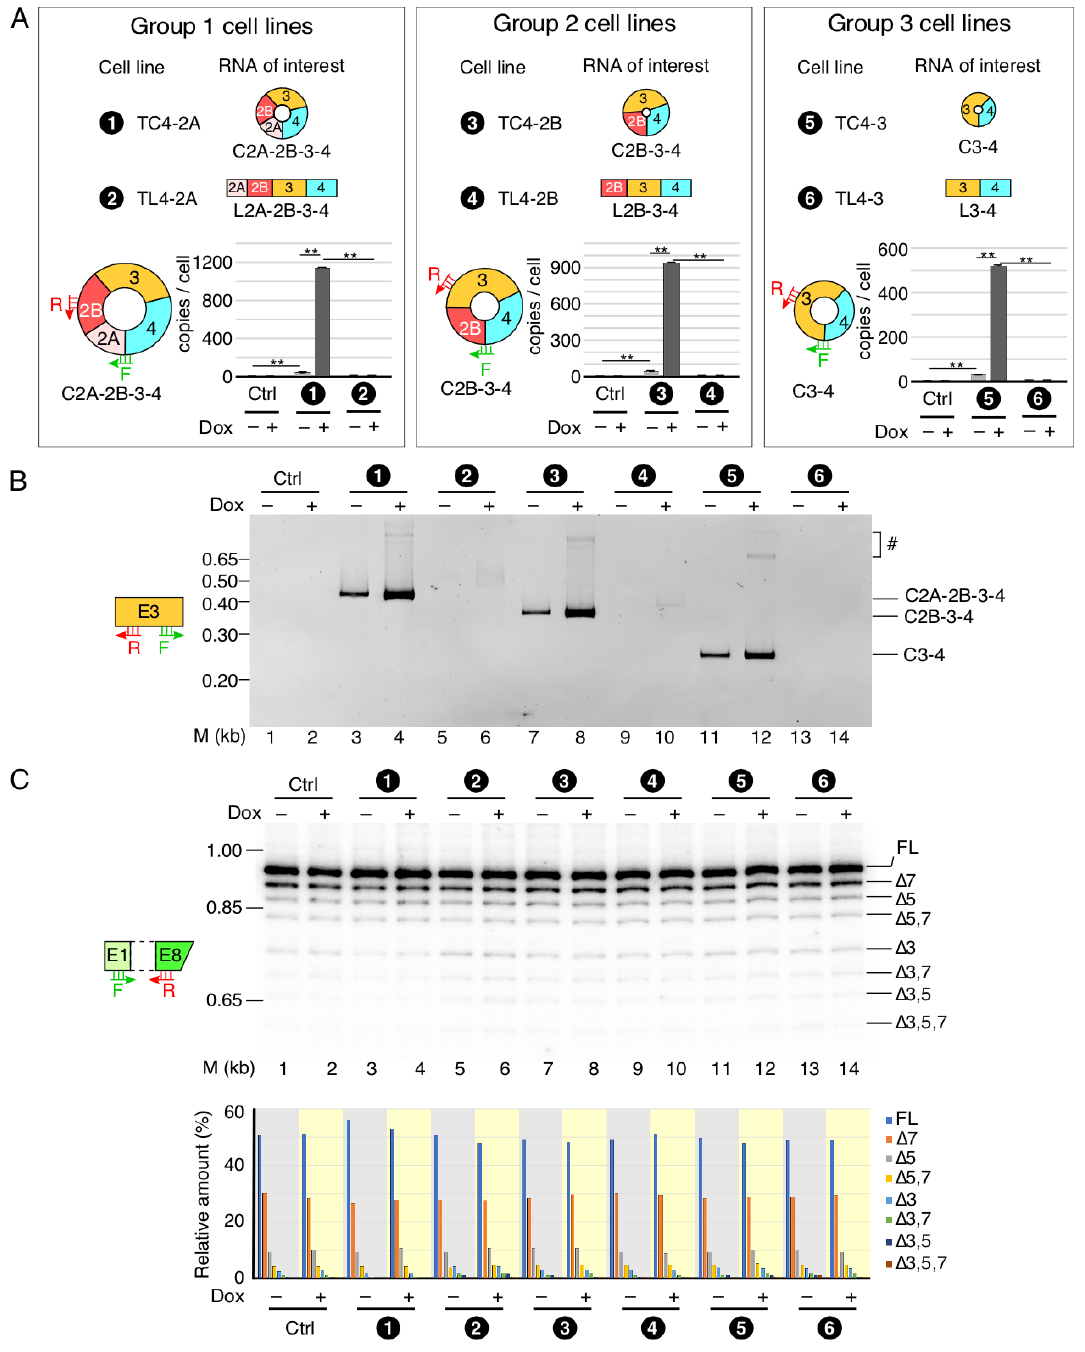
Figure 5. Comparative analysis of SMN RNA expression in stable cell lines. ( A ) Inducible expression of circRNA of interest in the established cell lines. Based on the number of exons in circular or linear transcripts, three groups of cell lines are shown. The names of each stable cell line are given as well, along with their number coding. Number coding used is as follows. (1) TC4-2A, stable cell line ex- pressing C2A-2B-3-4 circRNA. (2) TL4-2A, stable cell line expressing LC2A-2B-3-4 linear RNA pro- duced due to G1C mutation at the 5 ′ ss of exon 4. (3) TC4-2B, stable cell line expressing C2B-3-4 circRNA. (4) TL4-2B, stable cell line expressing L2B-3-4 linear RNA produced due to G1C mutation at the 5 ′ ss of exon 4. (5) TC4-3, stable cell line expressing C3-4 circRNA. (6) TL4-3, stable cell line expressing L3-4 linear RNA produced due to G1C mutation at the 5 ′ ss of exon 4. Bar diagrams show the copy number of the indicated circRNAs in the presence (+) or absence ( − ) of Dox, as determined by qPCR. Annealing positions of primers used are indicated. The original T-REx cell line was used as a control (Ctrl). Error bars represent standard error of the mean. Statistical significance: *, p < 0.05; **, p < 0.01. ( B ) A representative gel showing the results of semi-quantitative PCR for circRNA de- tection using divergent primers annealing to exon 3. Numbers at the top of the gel indicate stable cell lines as described in panel ( A ). Ctrl, control cell line. (+) and ( − ) represent presence and absence of Dox, respectively. The size marker (M) is indicated on the left side of gel, while the identity of the bands is indicated on the right side. The bands likely derived from duplicates of indicated circular